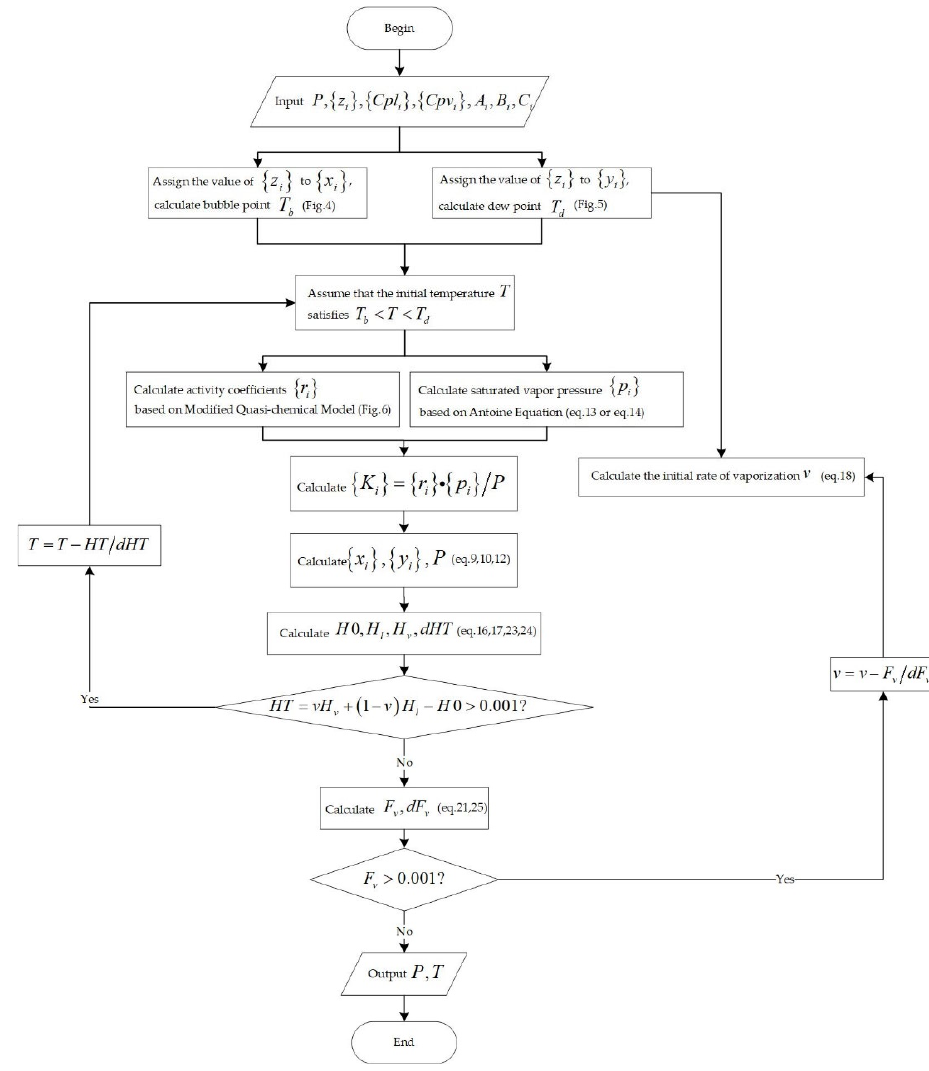
Figure 2. Flowchart for the calculation of adiabatic flash for narrow boiling range mixtures.